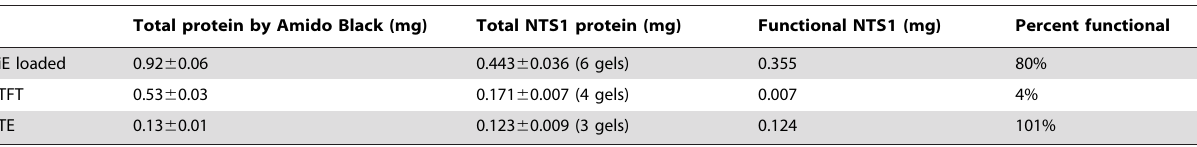
Total protein by Amido Black (mg) Total NTS1 protein (mg)